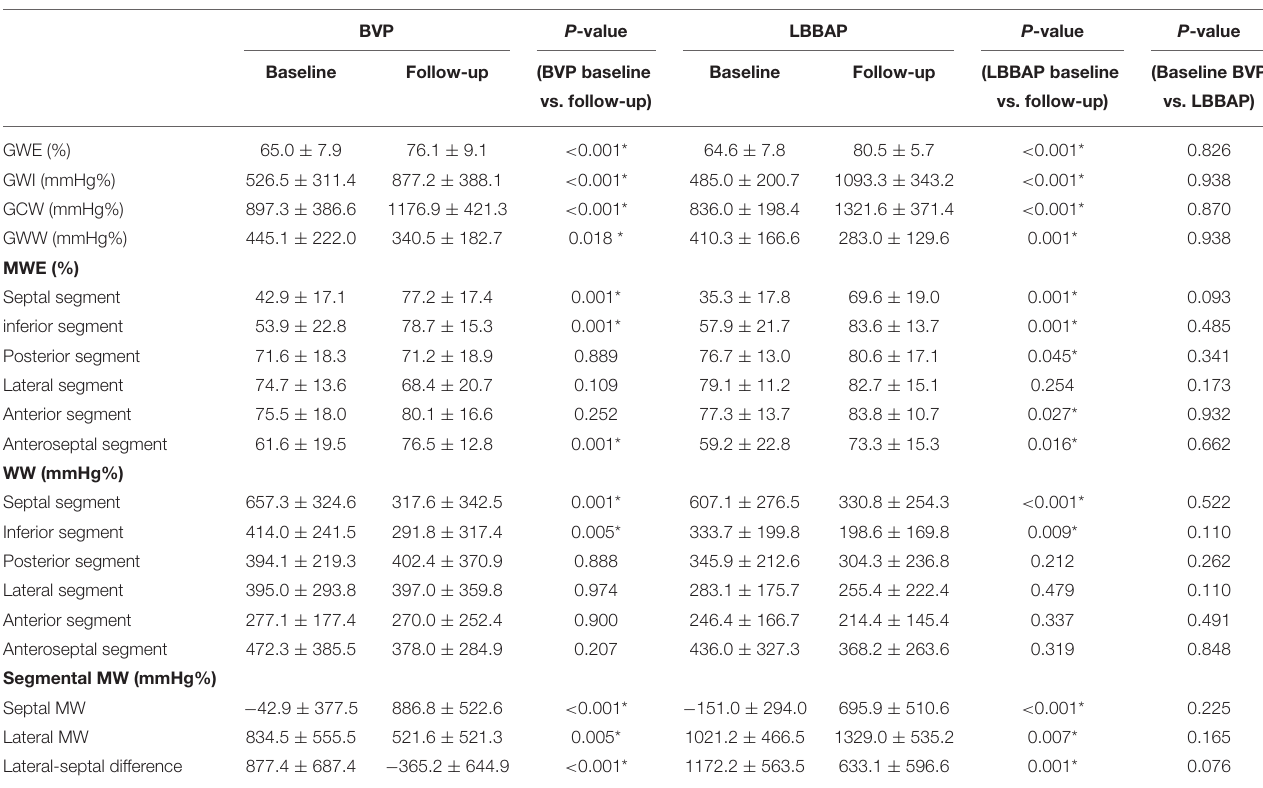
TABLE 4 | Global and segmental myocardial work in the LBBAP and BVP groups at baseline and follow-up. BVP P -value LBBAP P -value P -value Baseline Follow-up (BVP baseline Baseline Follow-up (LBBAP baseline (Baseline BVP vs. follow-up) vs. follow-up) vs.